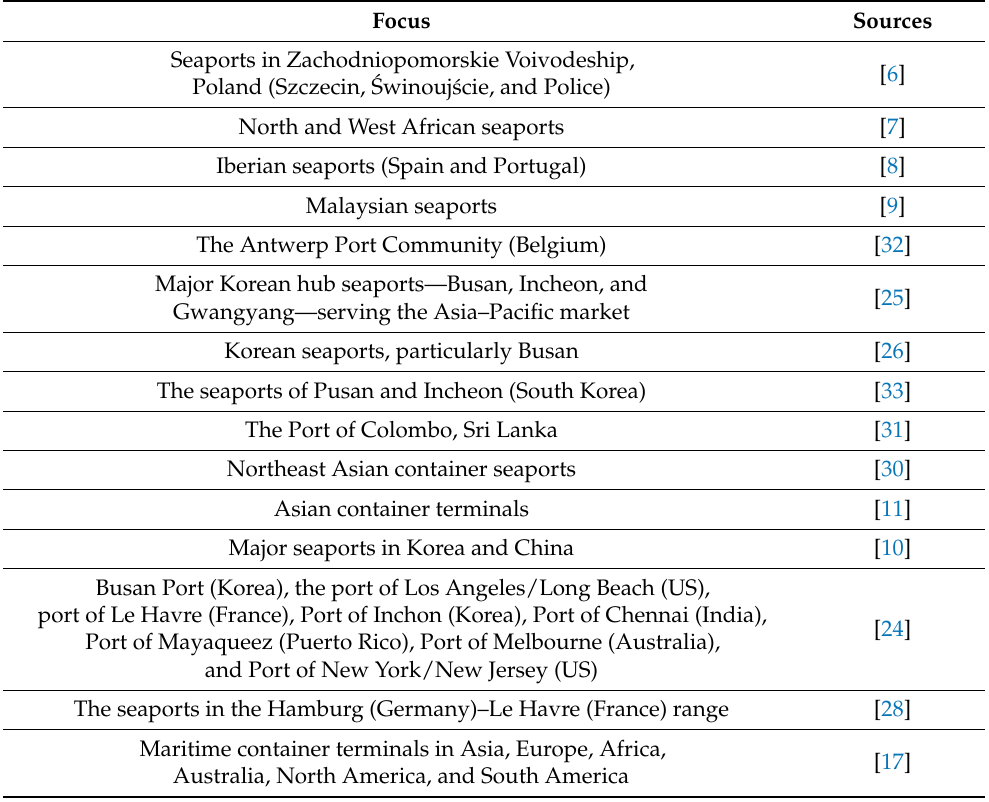
Table 2. The focus of identified resources. Focus